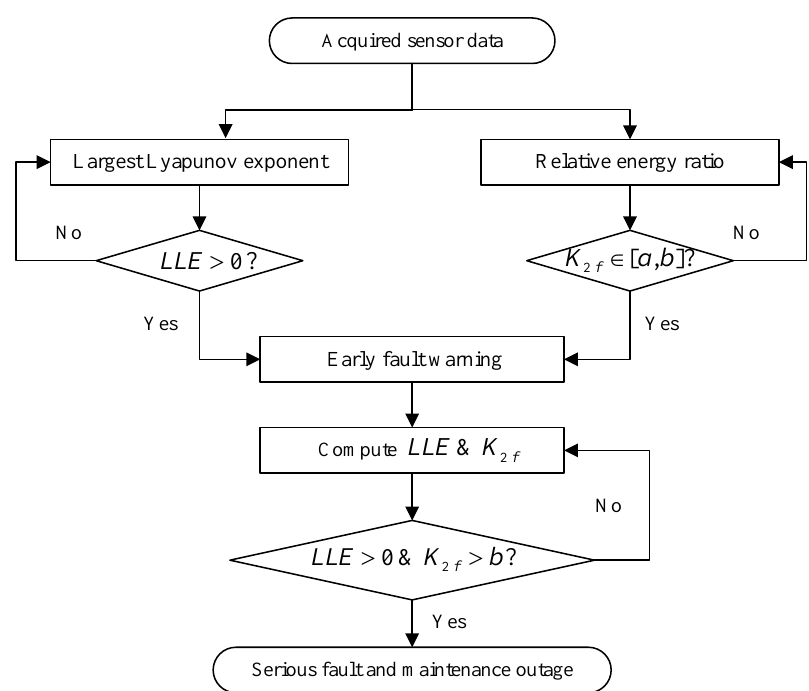
Figure 13. The flow chart of the proposed quantitative identification and abnormality alarm strategy.